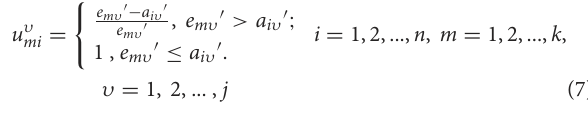
Patient Age Sex Illness number